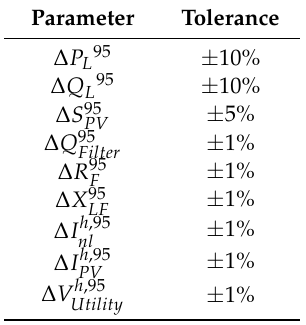
Table 3. Tolerances used for the deviations of the studied parameters from their mean